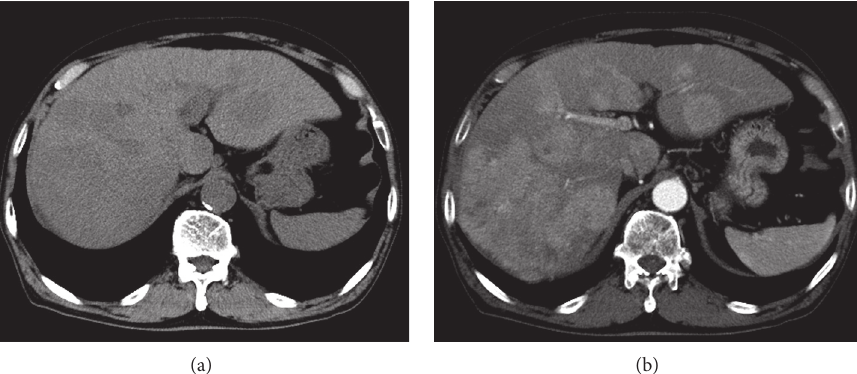
Figure 1: Nonenhanced computed tomography (a) and arterial phase of CT (b). Multiple liver tumors are depicted as low attenuation areas in nonenhanced CT and exhibited early enhancement in the arterial phase. These tumors were considered hepatocellular carcinomas.